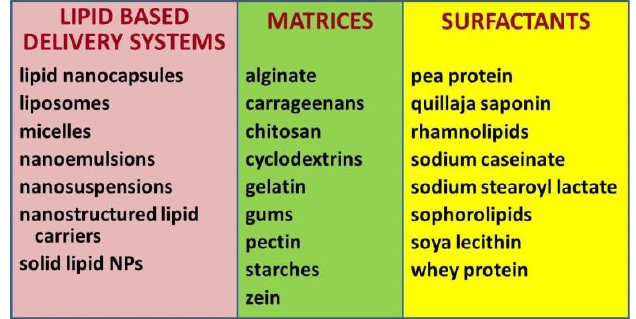
Figure 1. Nanoscale lipid-based delivery systems, matrices and surfactants most frequently used in nanoformulations of nutraceuticals.